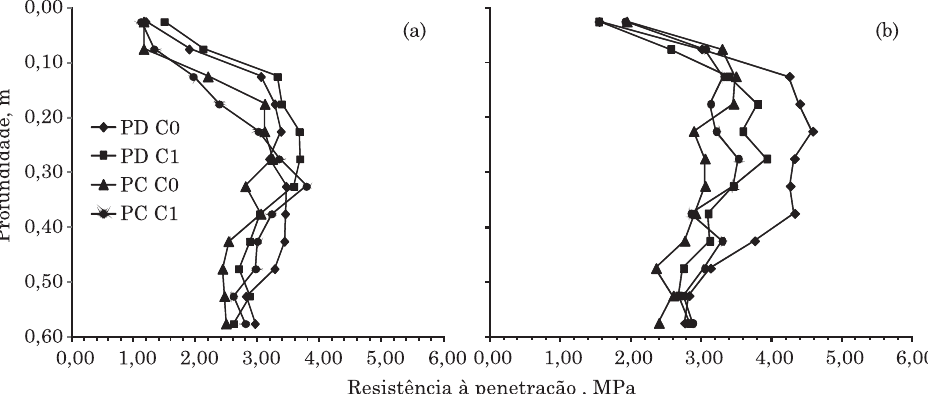
Figura 1. Valores da resistência à penetração por camada de solo nas posições linha (a) e entrelinha (b) na época de máximo excedente hídrico (Época 3), nos tratamentos plantio direto (PD), plantio convencional (PC), sem calcário (C0) e com 2,0 t ha -1 de calcário